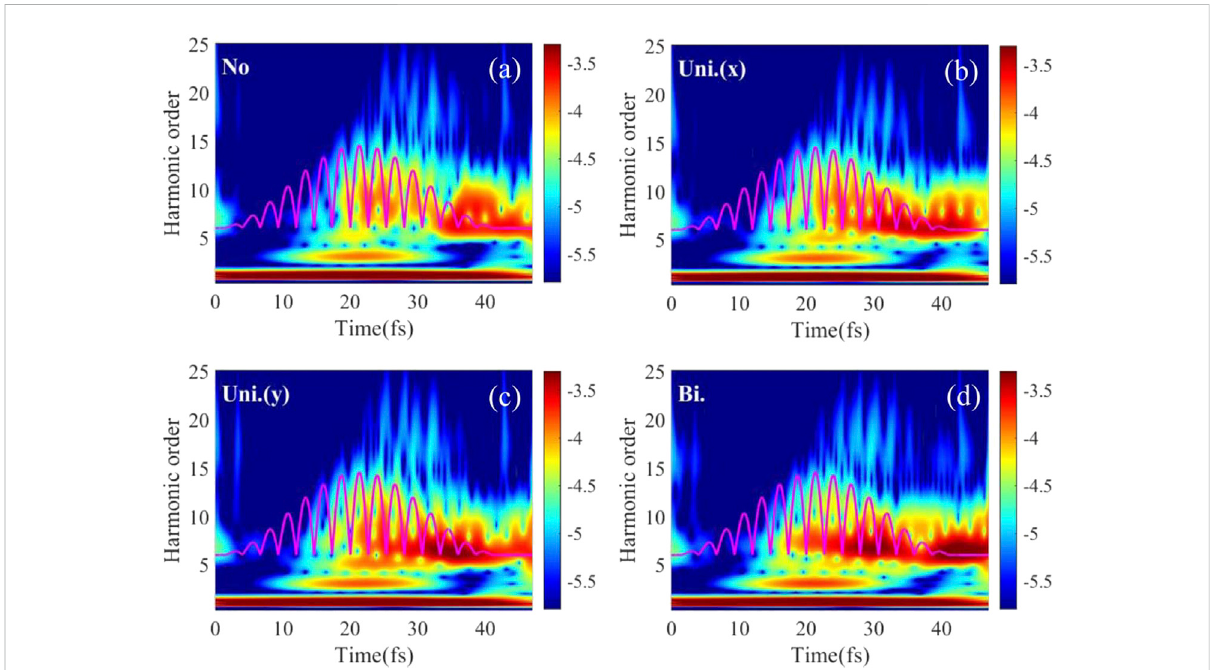
FIGURE 4 Thetime-frequencylogarithmicintensityof x -polarizedharmonicsunderdifferentstretchingpercents,radiatedbyalinearpolarizedlaserpulse alongthe x direction: (A) strain-free;onlyuniaxialstretchingimposedalong (B) the x directionwith ε uni.(x) =6%and (C) the y directionwith ε uni.(y) =6%; (D) biaxial stretching with ε bi . =